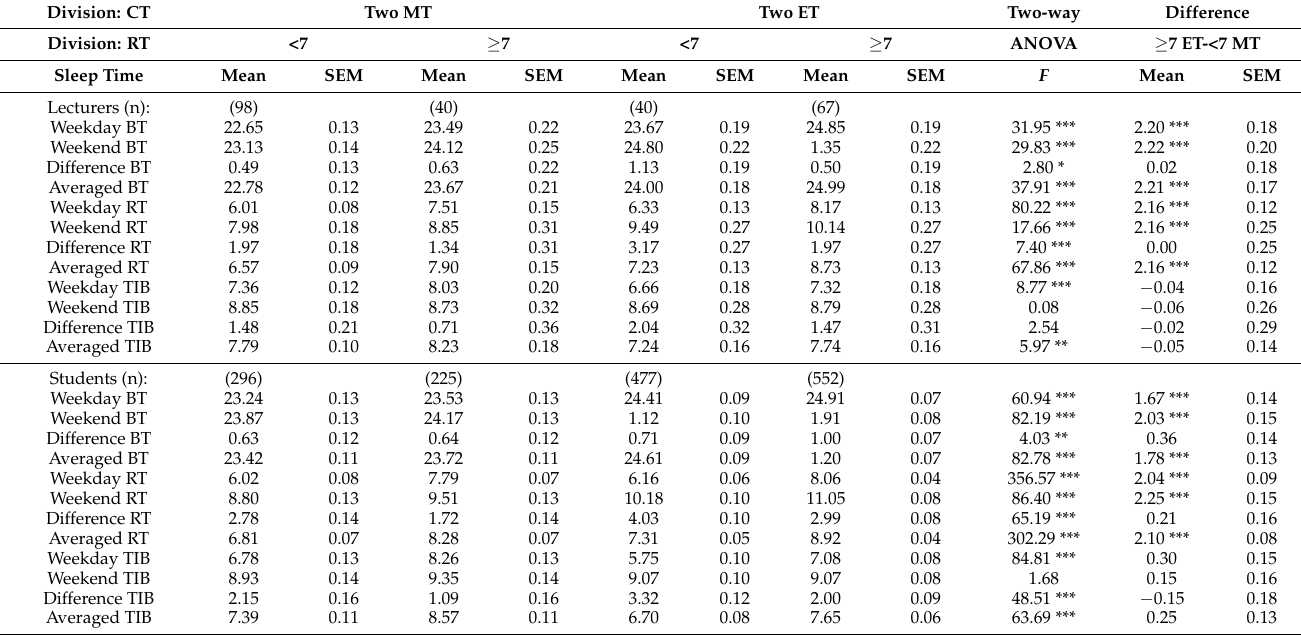
Table 4. Statistical differences in sleep times: early morning types and late evening types.